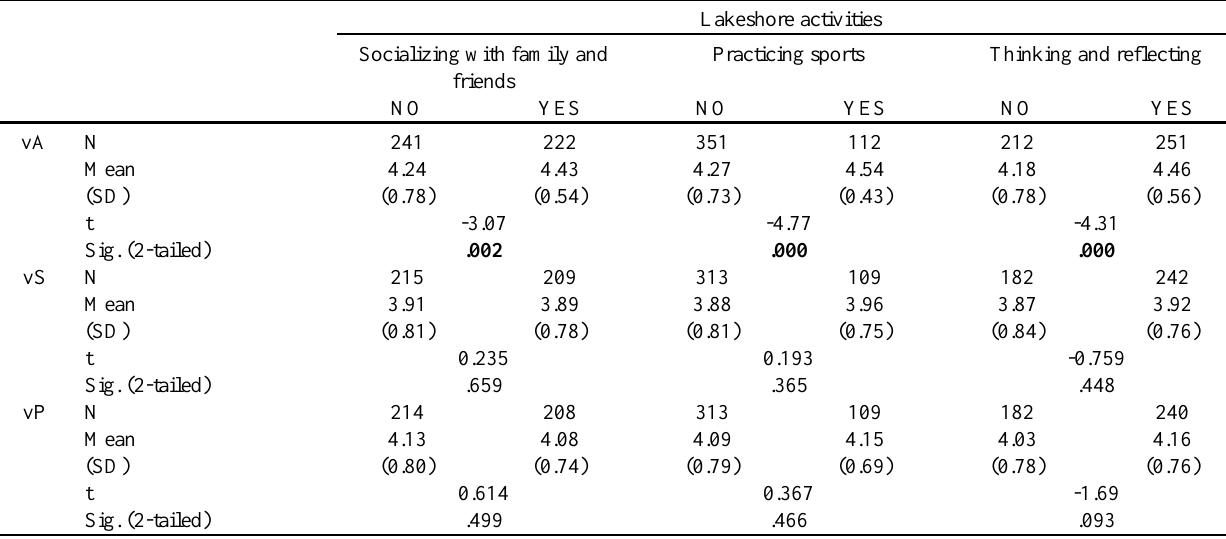
Table 3. Differences in vA, vS, and vP scores for different groups of lakeshore users Lakeshore activities Socializing with family and Practicing sports Thinking and reflecting friends NO YES NO YES NO YES 241 222 351